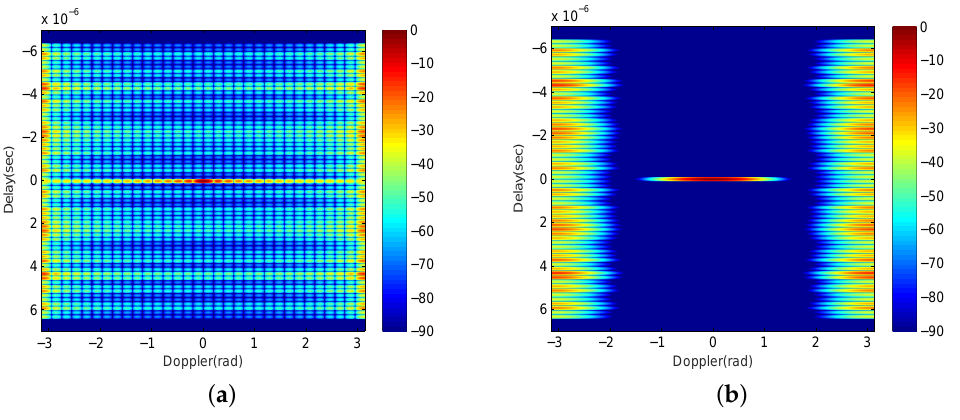
Figure 4. The AF of Golay complementary waveforms based on ( a ) standard transmission order; ( b ) Binomial Design algorithm (the unit of colorbar is